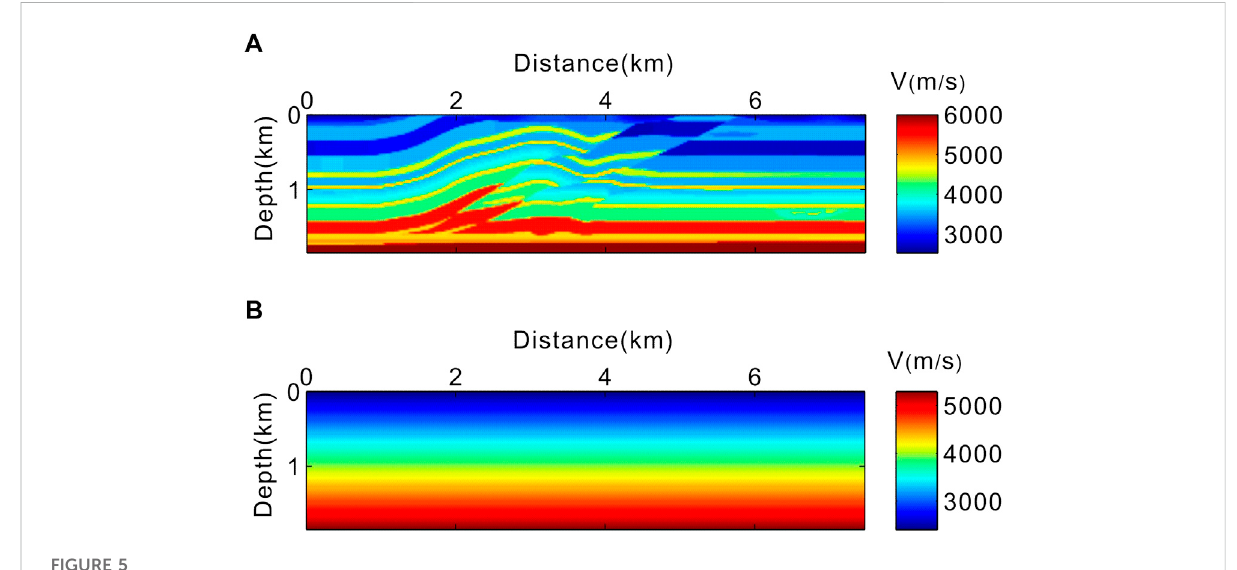
FIGURE 5 (A) True model and (B) initial model for the Overthrust model